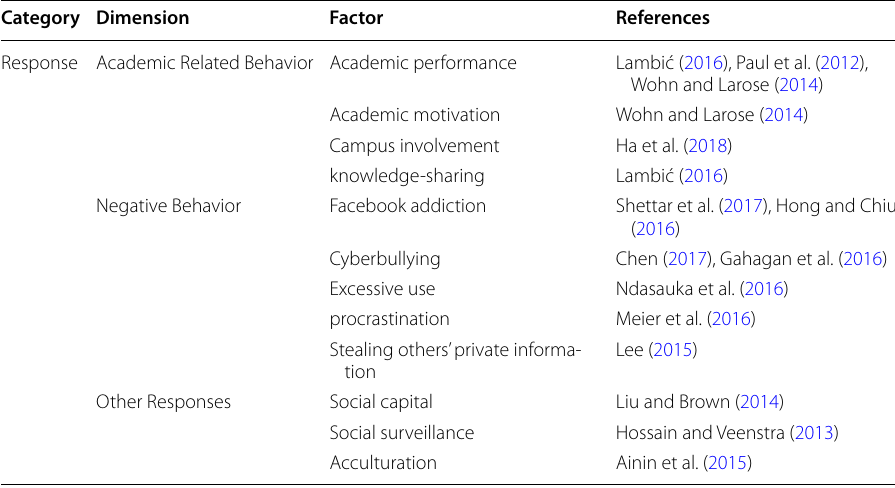
Table 6 Summary of students’